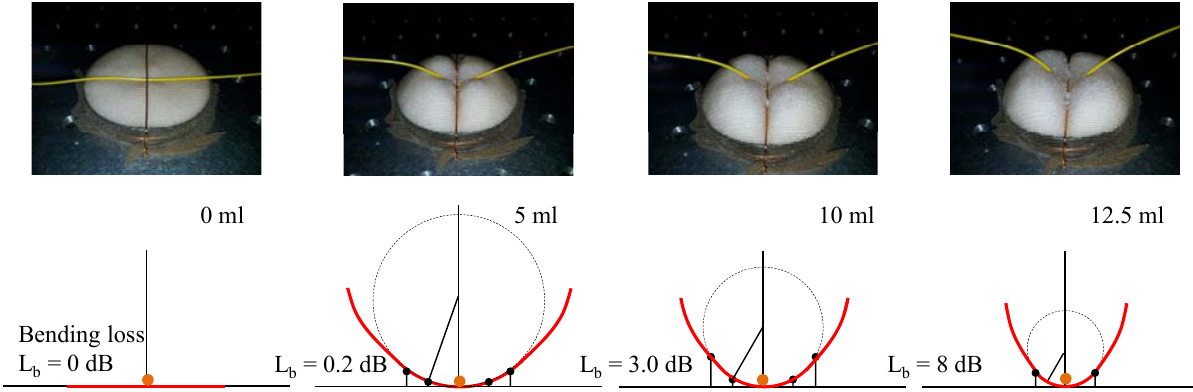
Figure 10. Bending loss according to bending diameters and arc angles of an optical fiber